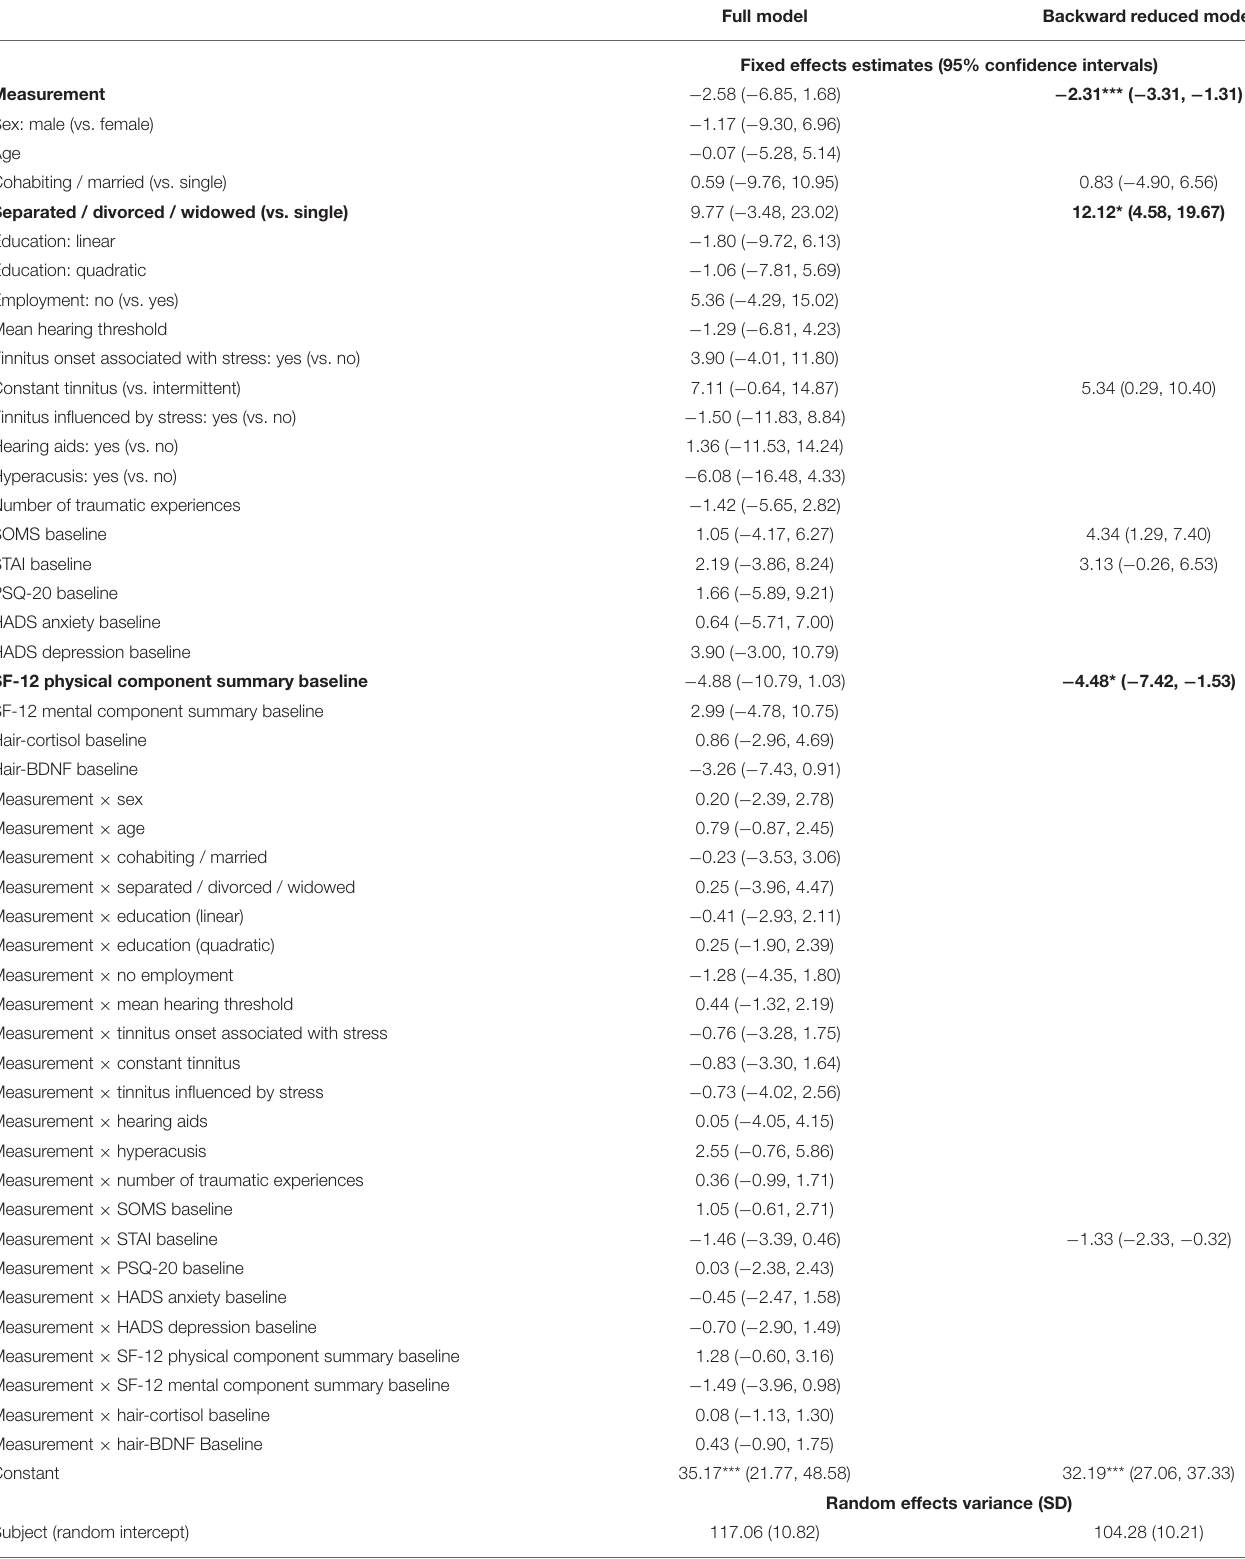
TABLE 3 | Full and backward reduced linear mixed-effects models for change in Tinnitus Questionnaire (TQ) scores across baseline, treatment end, and follow-up ( N =